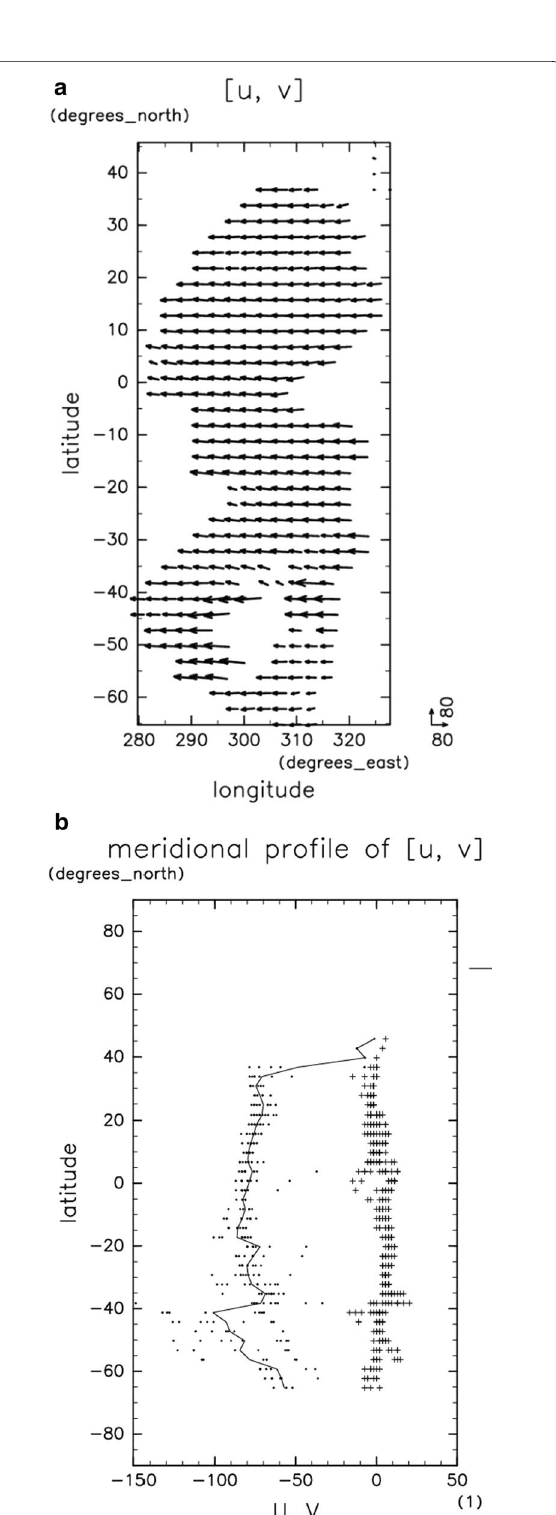
Fig. 13 a Preliminary results of wind vectors by cloud‑tracking pro‑ cedure from images in Fig. 12a, b. b Preliminary latitudinal distribu‑ tion of zonal (dots) and meridional (crosses) mean wind speed. The mean zonal wind speed of 214 vectors between